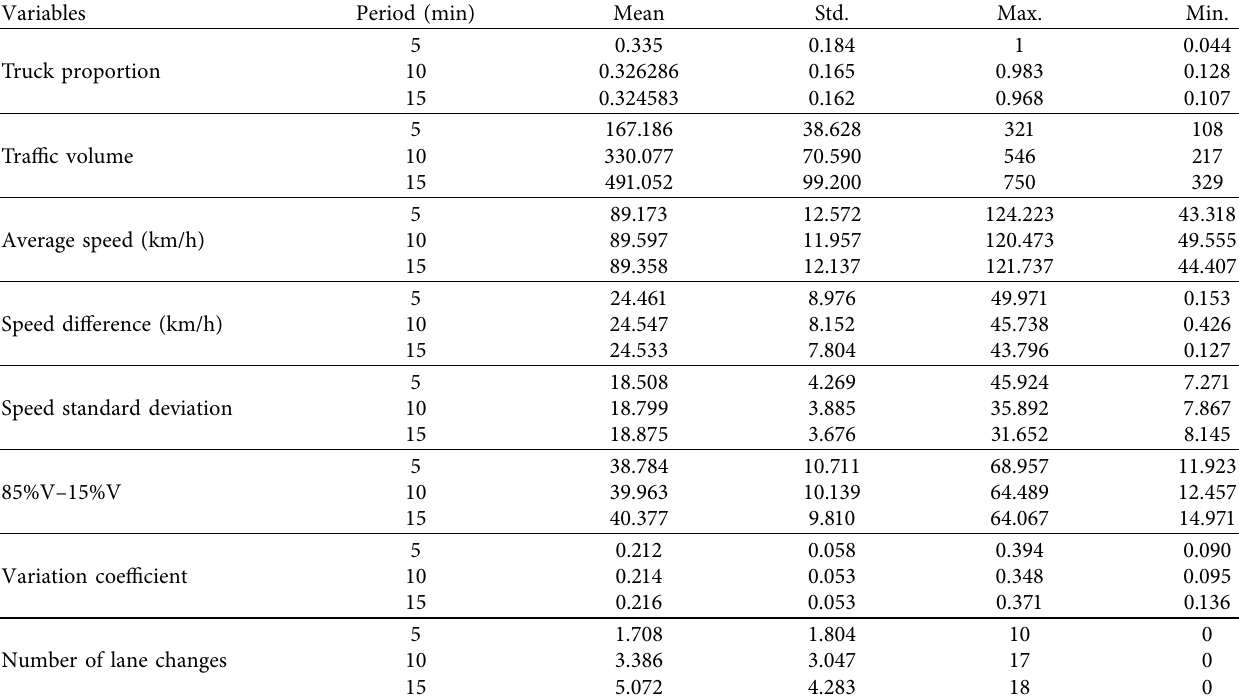
Table 2: The data of collected parameters after preliminary statistics in different periods.